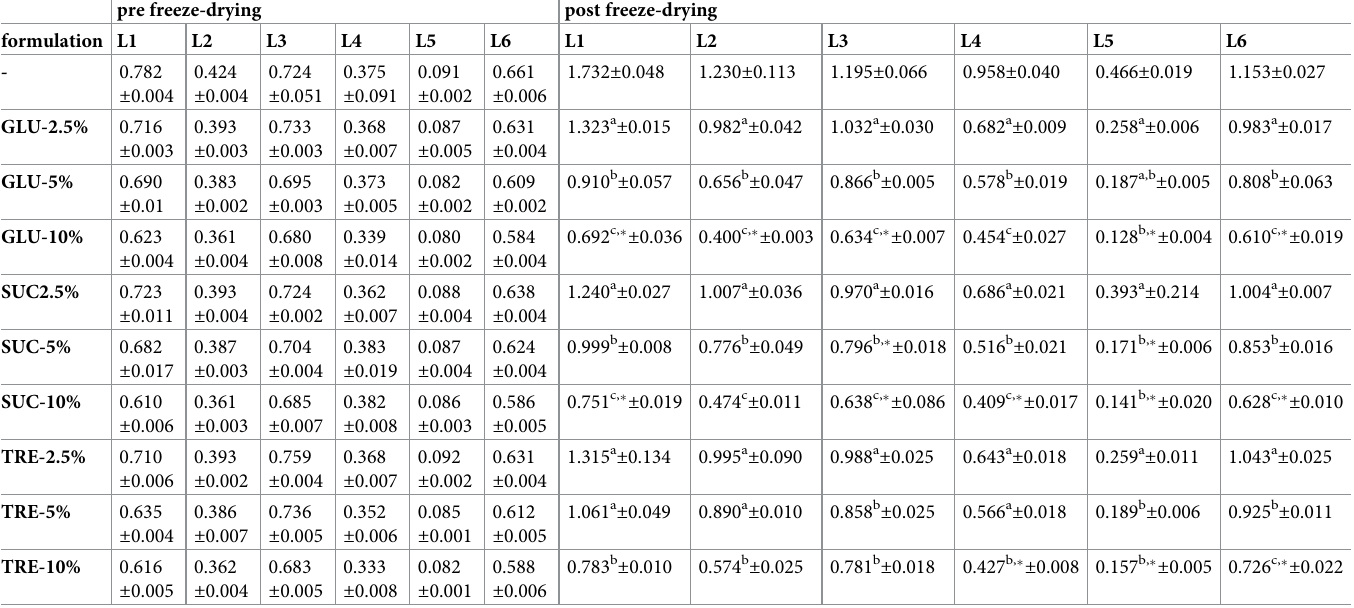
Table 1. Turbidity of plasma after freeze-drying and rehydration. Spectroscopic analysis of plasma turbidity (i.e. absorbance at 550 nm), both before and after freeze- drying of plasma without supplements (-) as well as supplemented with 2.5 − 10% glucose (GLU), sucrose (SUC) or trehalose (TRE). Plasma from six different donors was analyzed (L1 − 6), with performing three technical replicates each. Mean ± standard deviations are presented, while statistically significant (p < 0.05) differences amongst the time point of analysis (i.e. pre versus post freeze-drying) are indicated with an asterisk, and those between different sugar concentrations used (post freeze-drying data only) are indicated with different superscript letters. Values between different donors were statistically significant for all